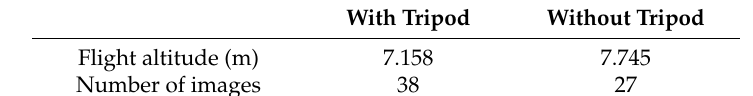
Table 4. Flight parameters.